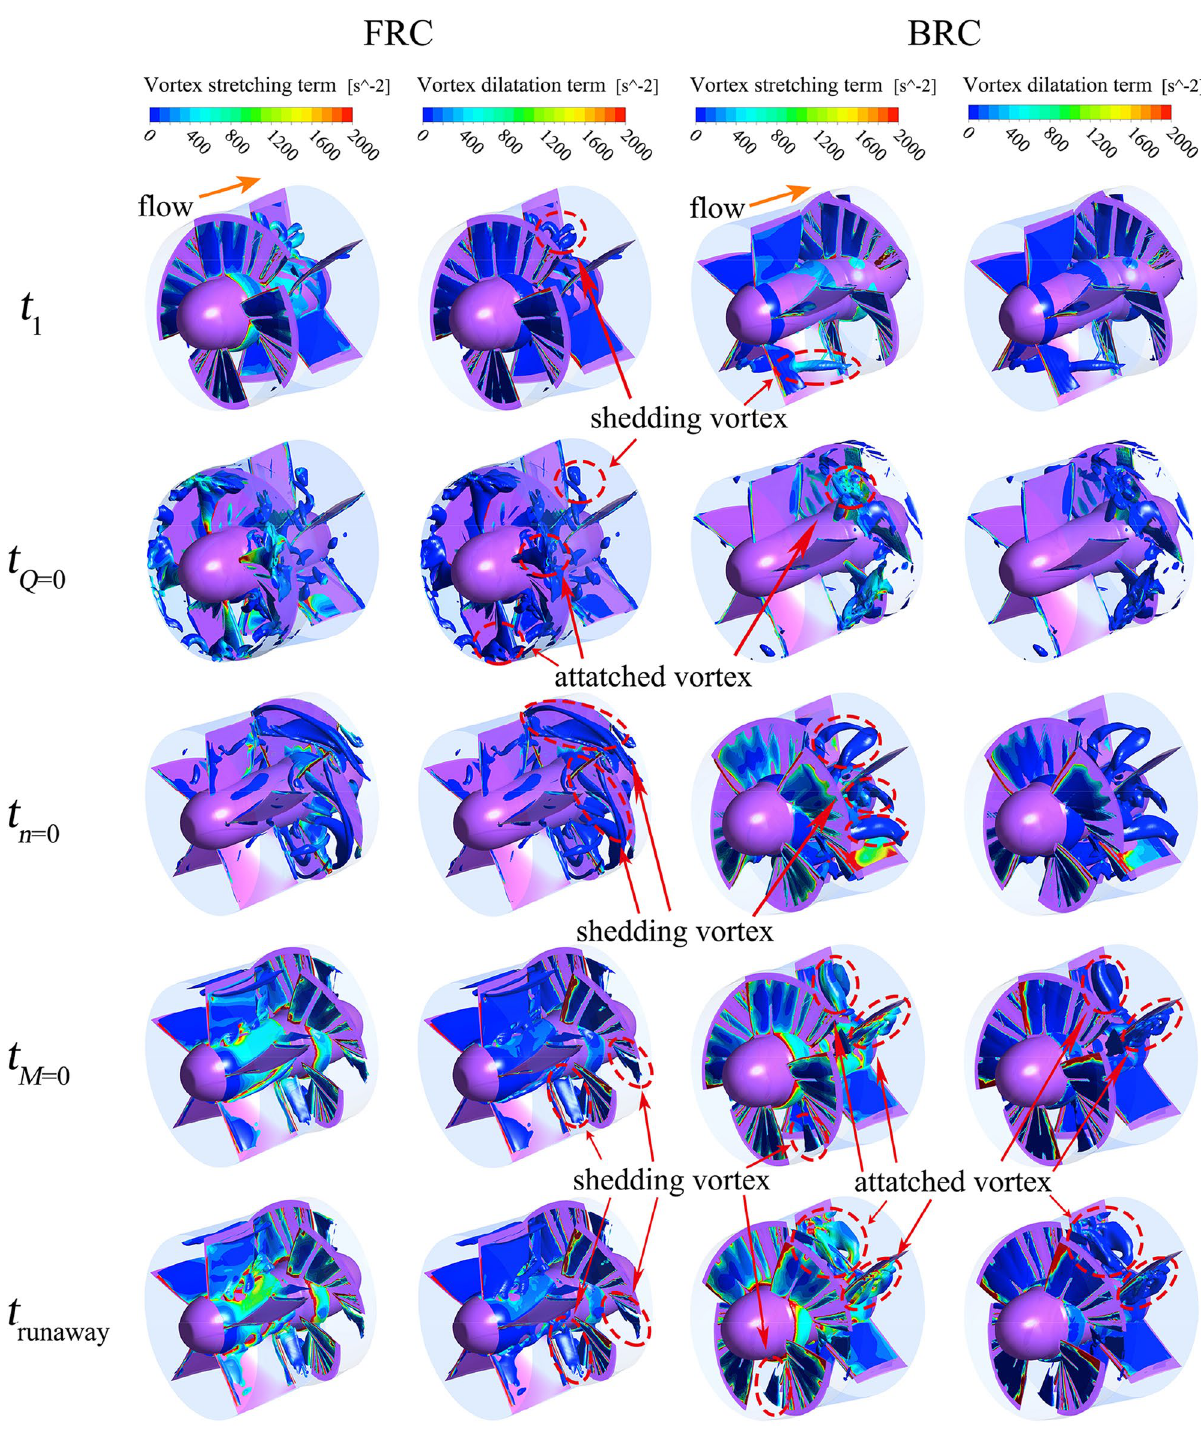
Figure 15. Vortex core at Q = 50/s 2 , and vortex stretching term and vortex dilatation term distribution in